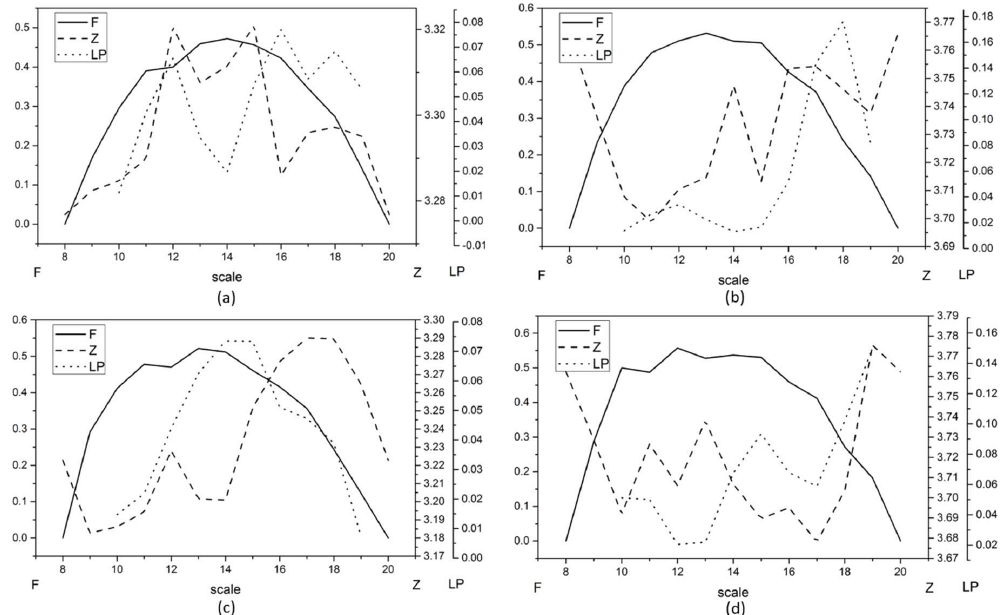
Figure 6. The unsupervised evaluation (UE) results of segmentations produced by the MRS method with a scale of 8–20 for the four study areas: ( a ) T1, ( b ) T2, ( c ) T3, and ( d ) T4.